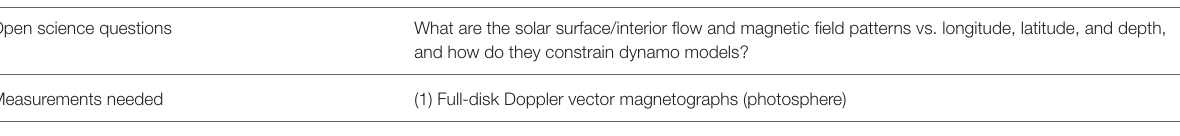
TABLE 1 | Solar interior and dynamo studies enabled by extra-SEL